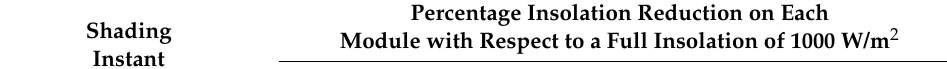
Table 5. Percentage insolation reduction taking as a reference the full insolation on the four PV modules for every timeslot of the “increasing insolation” dynamic PS scenario.